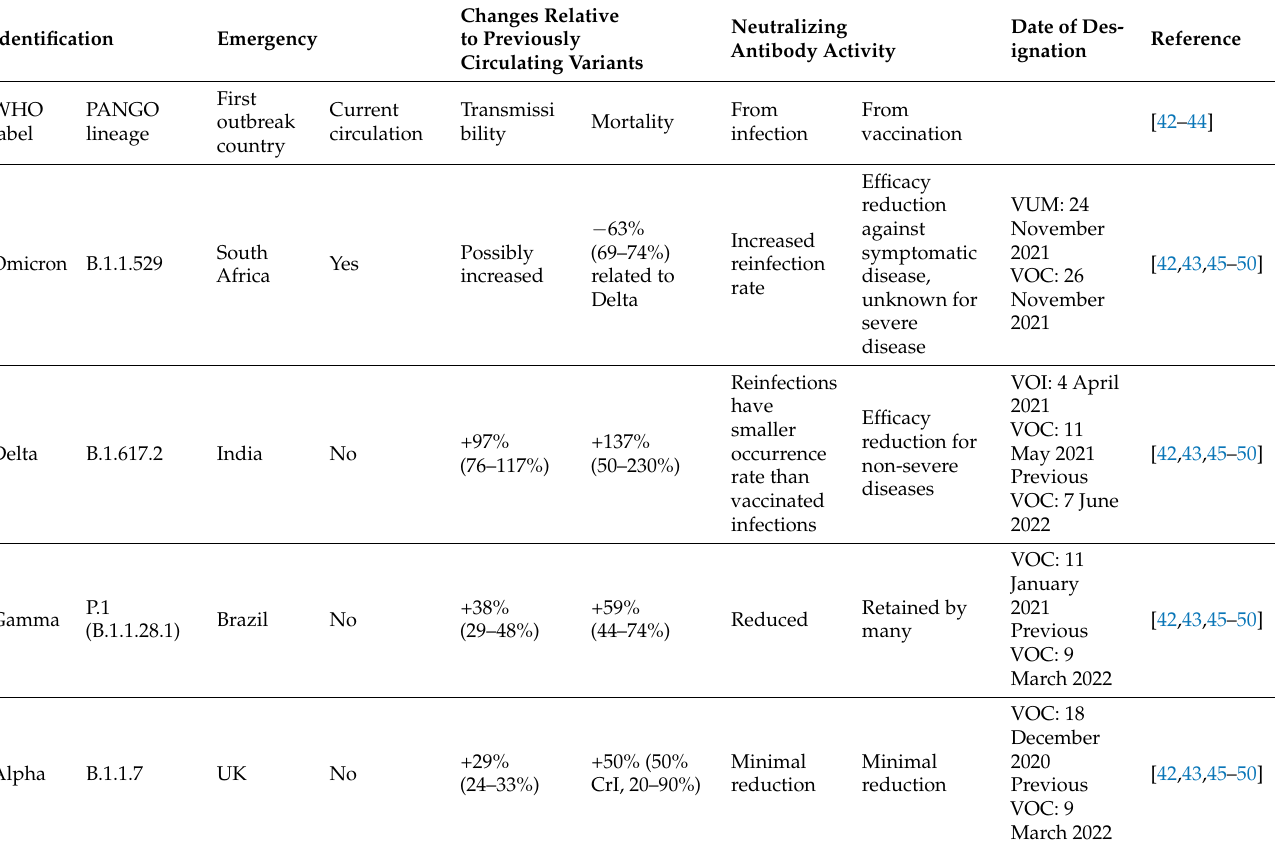
Table 2. The identification, emergency, changes, and neutralizing antibody activity of SARS-CoV-2 variants, called variants of concern (VOCs), during